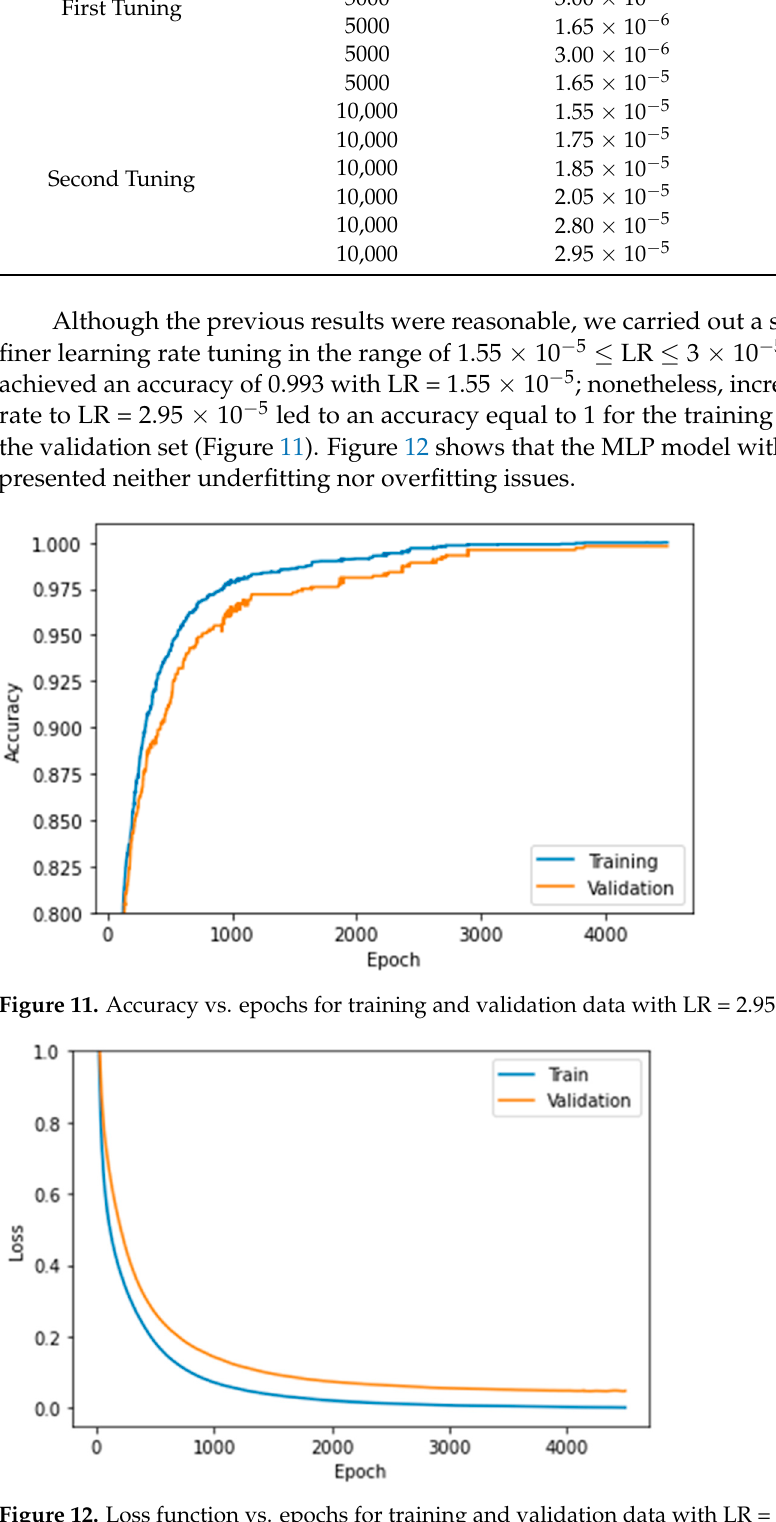
Figure 12. Loss function vs. epochs for training and validation data with LR = 2.95 × 10 − 5 .